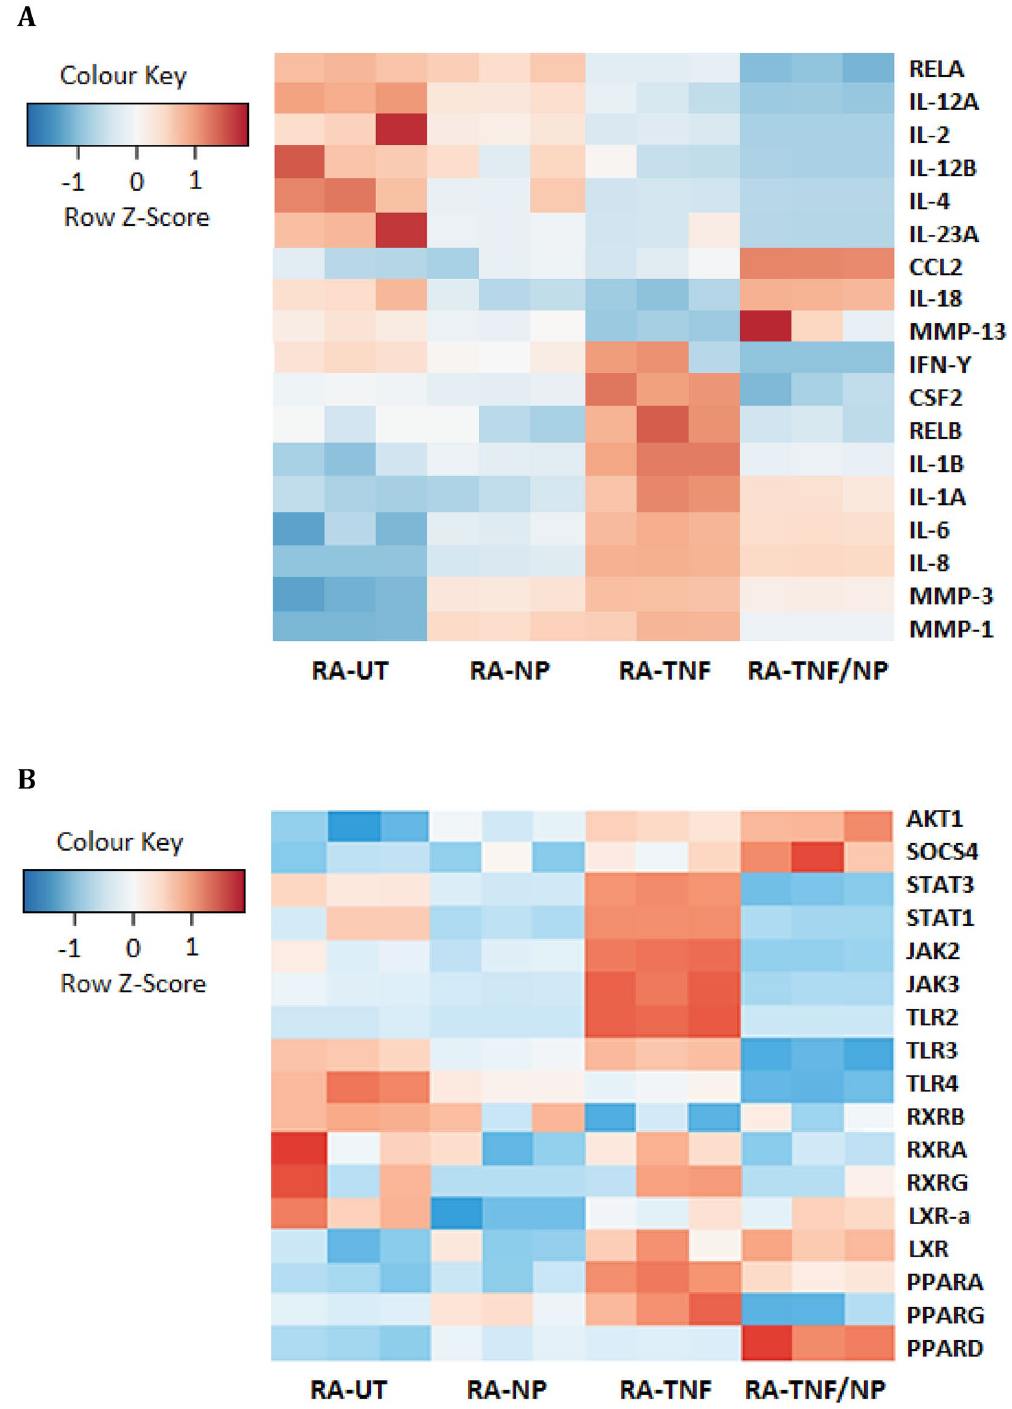
Figure 6. Heat map of differential expressed genes prominent in arthritis progression in RA-FLS cells. Groups included untreated RA-FLS cells (RA-UT), TNF-α stimulated cells (RA-TNF), NP and TNF-α stimulated cells (RA-TNF/NP), and NP treated cells (RA-NP). The normalized RNA-seq data is in log2 scale, where red is highly expressed genes and blue is low expression. To be included in the heat map, genes were required to have at least 1000 counts (reads), totalled over all samples, where the standard deviation of log2 expression differences had to exceed two. ( A ) Heat map of DE candidate genes prominent in arthritis progression in RA-FLS cells. The heatmap highlight anti-inflammatory effects of NP in TNF-α induced pro-inflammatory cytokine expression. Abbreviations: NF-κβ subunits (RELB, RELA); Interferon, (IL-(12A, 12, 12B, 4, 23A, 18, 1B, 1A, 6, 8)); Matrix metalloproteinases (MMP-[1, 3, 13]); chemokine ligand 2 (CCL2); colony-stimulating factor 2 (CSF2). ( B ) Heat map of DE candidate signalling genes. The heatmap highlight shift in gene expression following NP treatment. Abbreviations: Serine/threonine-protein kinase (AKT1); Suppressor of cytokine signalling 4 (SOCS4); Janus kinase (JAK-[2, 3]); Signal transducers and activators of transcription (STAT-[1, 3]); Toll like receptor (TLR-[2–4]); Liver X receptor (LXR-[α]); Retinoid X receptor (RXR); Peroxisome proliferator- activated receptors (PPAR [A,G,D]-[α, ɣ ,